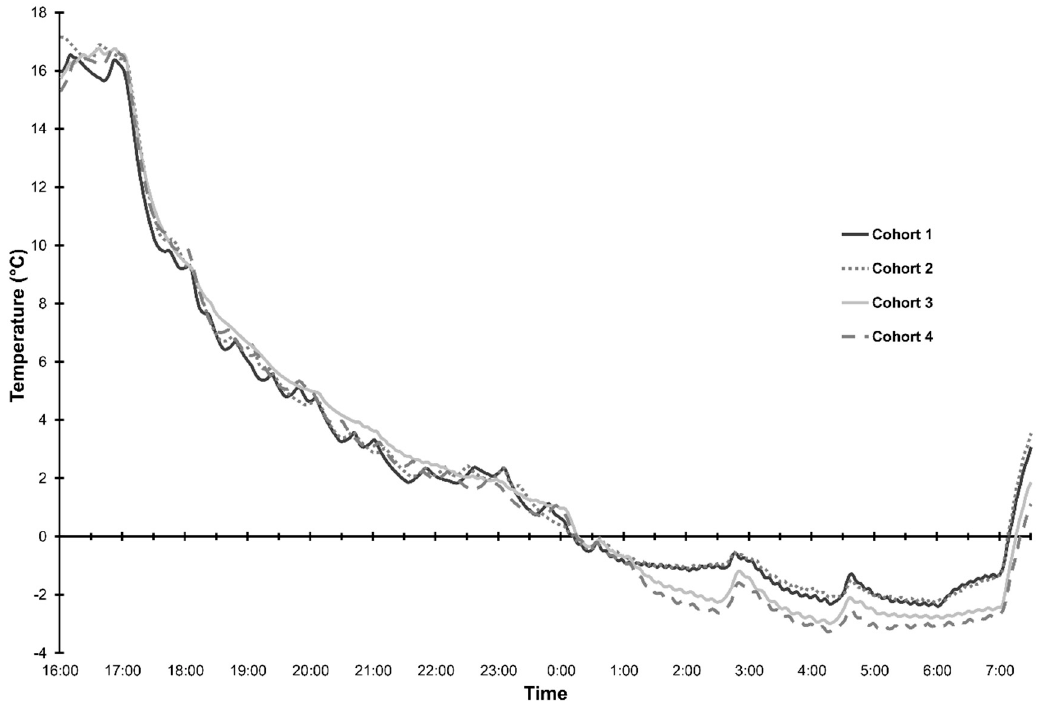
Figure 1. Temperature at one-minute intervals for Cohorts 1–4 recorded by TinyTag ® temperature loggers mounted at plant head height under the canopy cover for the duration of each